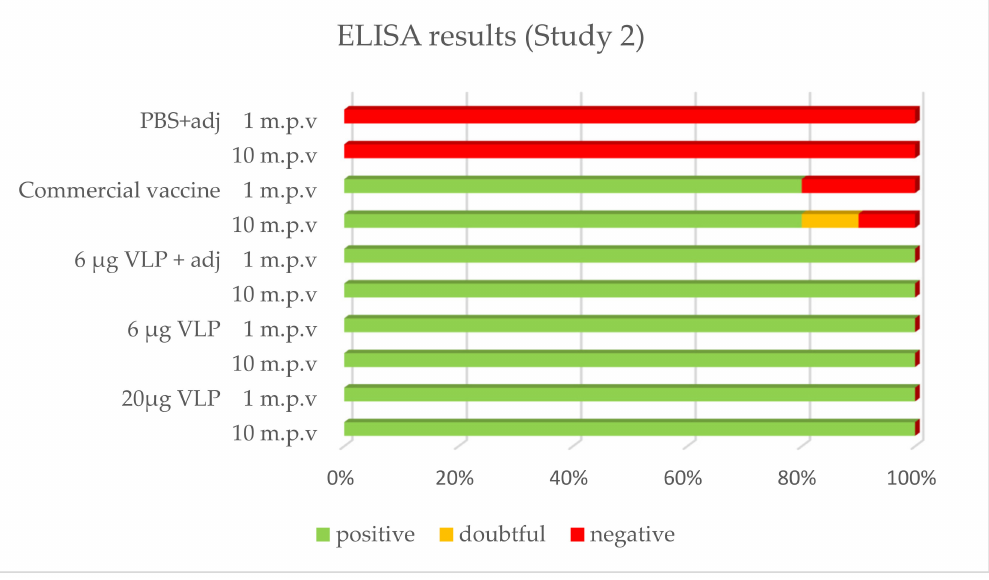
Figure 5. Prevalence of RGNNV-specific IgM in ELISA (Study 2). Plasma from sea bass 1 ( n = 3–5) or 10 ( n = 10) months post-vaccination